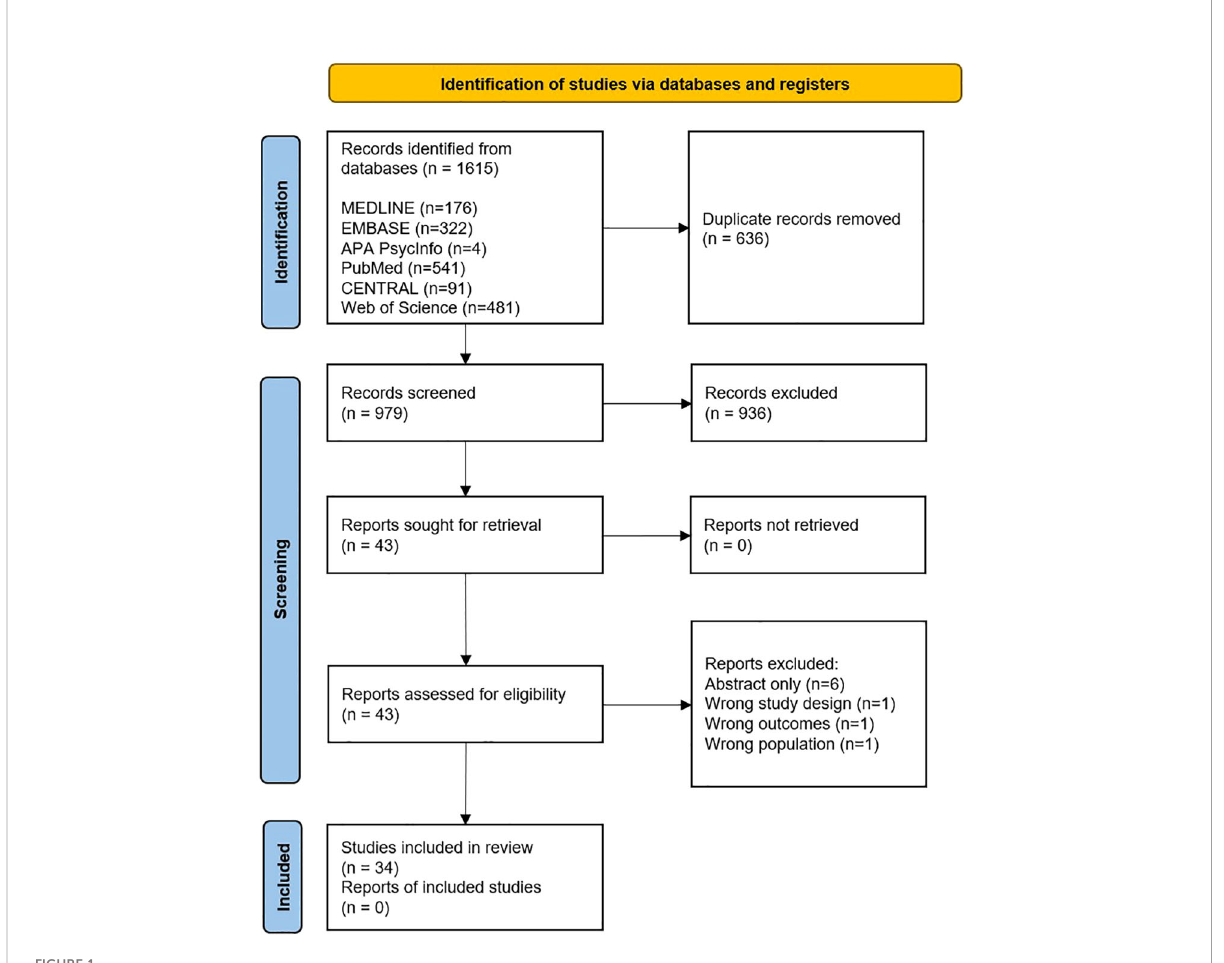
FIGURE 1 PRISMA chart for the